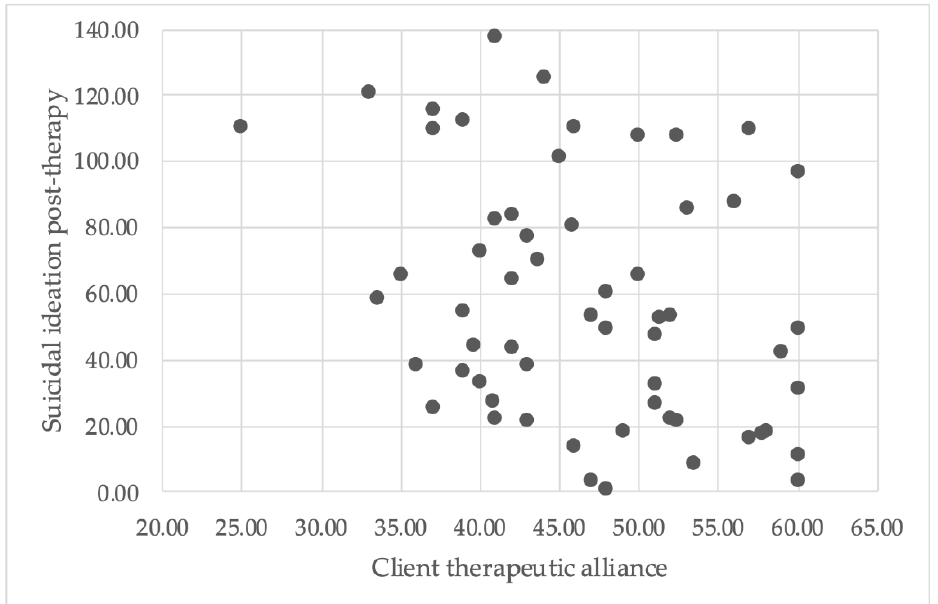
Figure 3. A scatterplot illustrates the relationship between client therapeutic alliance scores and severity of suicidal ideation post-therapy.